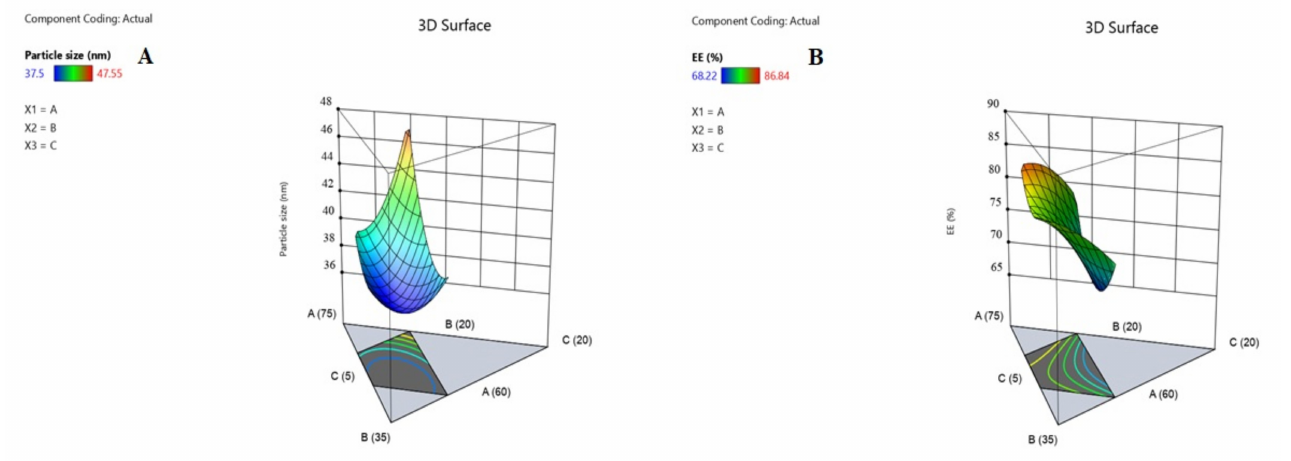
Figure 3. Three-dimensional surface plot for the interaction of different critical process parameters on OZ polymeric micelles’ particle size ( A ) and EE% ( B